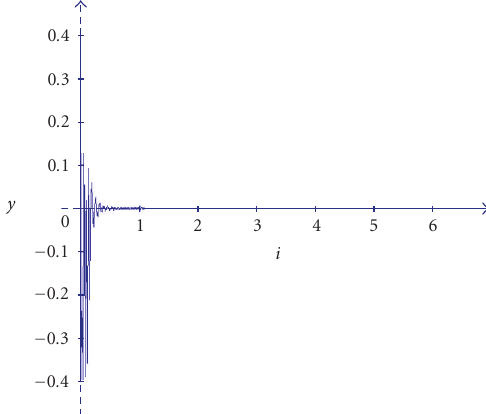
Figure 6.21 . Stable solution of (5.2) in the point A 0 (5 . 2,1), p = 0, h = 2 . 4, Δ = 1 . 2, a 0 = 5.